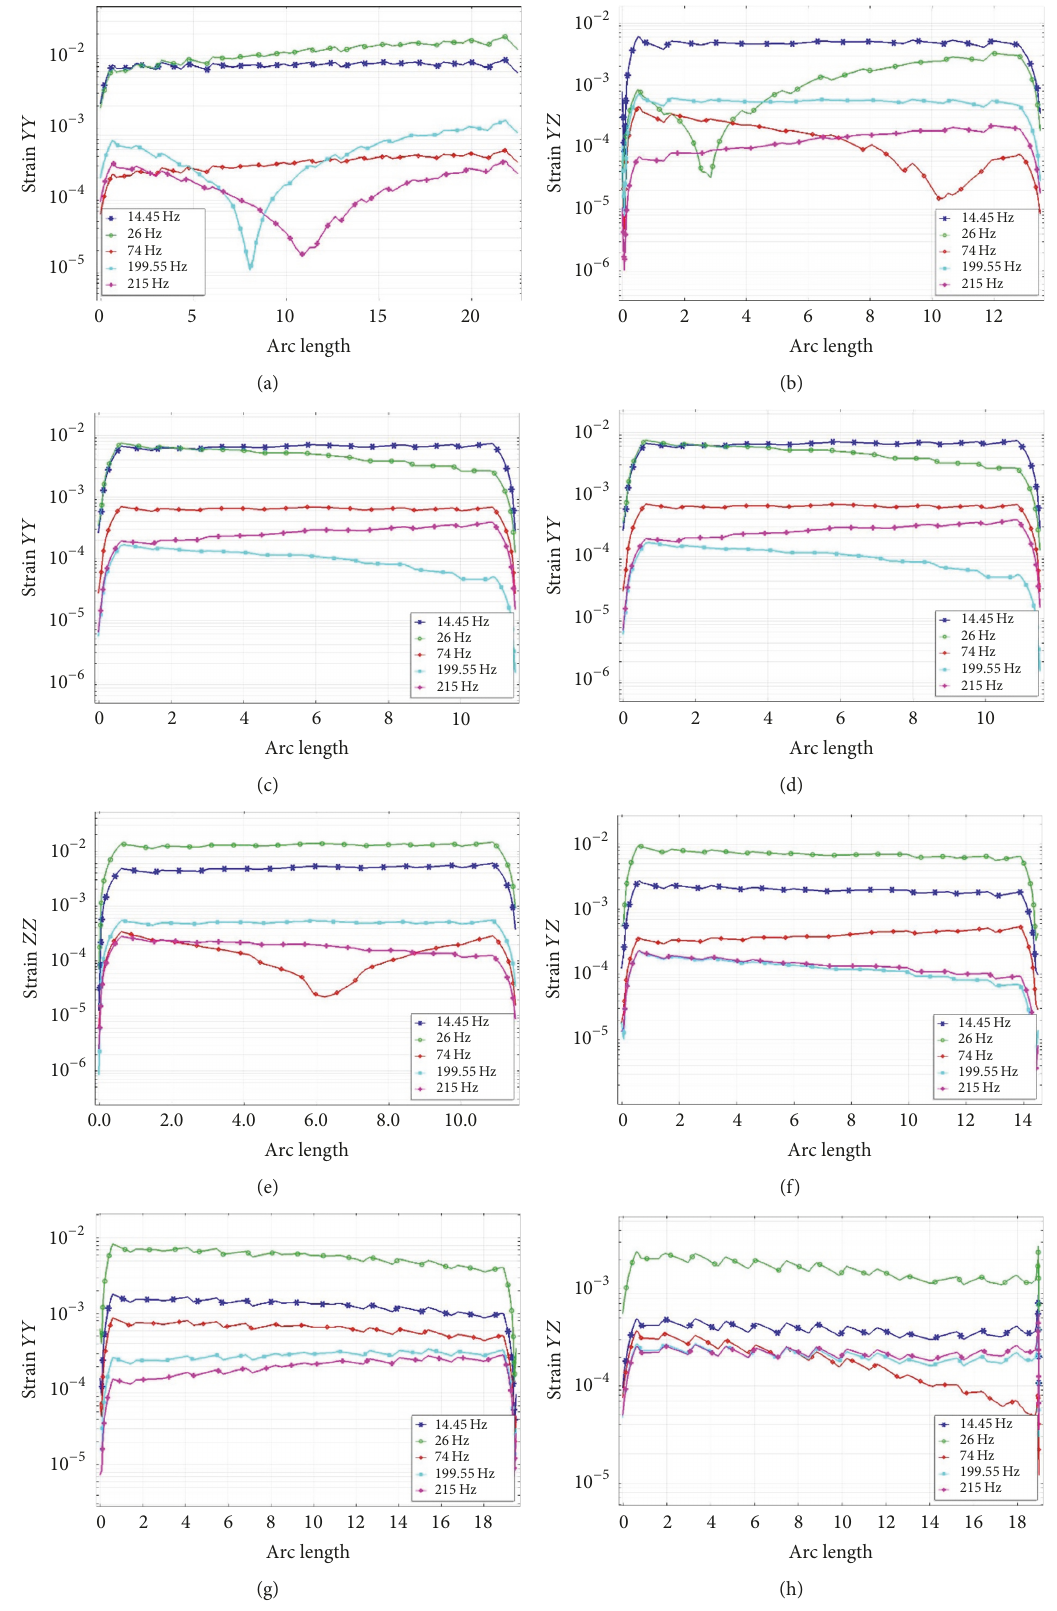
Figure 6: Strain characteristics at the cantilevers; (a) at 𝐿 1 ; (b) at 𝐿 2 ; (c) at 𝐿 3 ; (d) at 𝐿 4 ; (e) at 𝐿 5 ; (f) at 𝐿 6 ; (g) at 𝐿 7 ; (h) at 𝐿 8